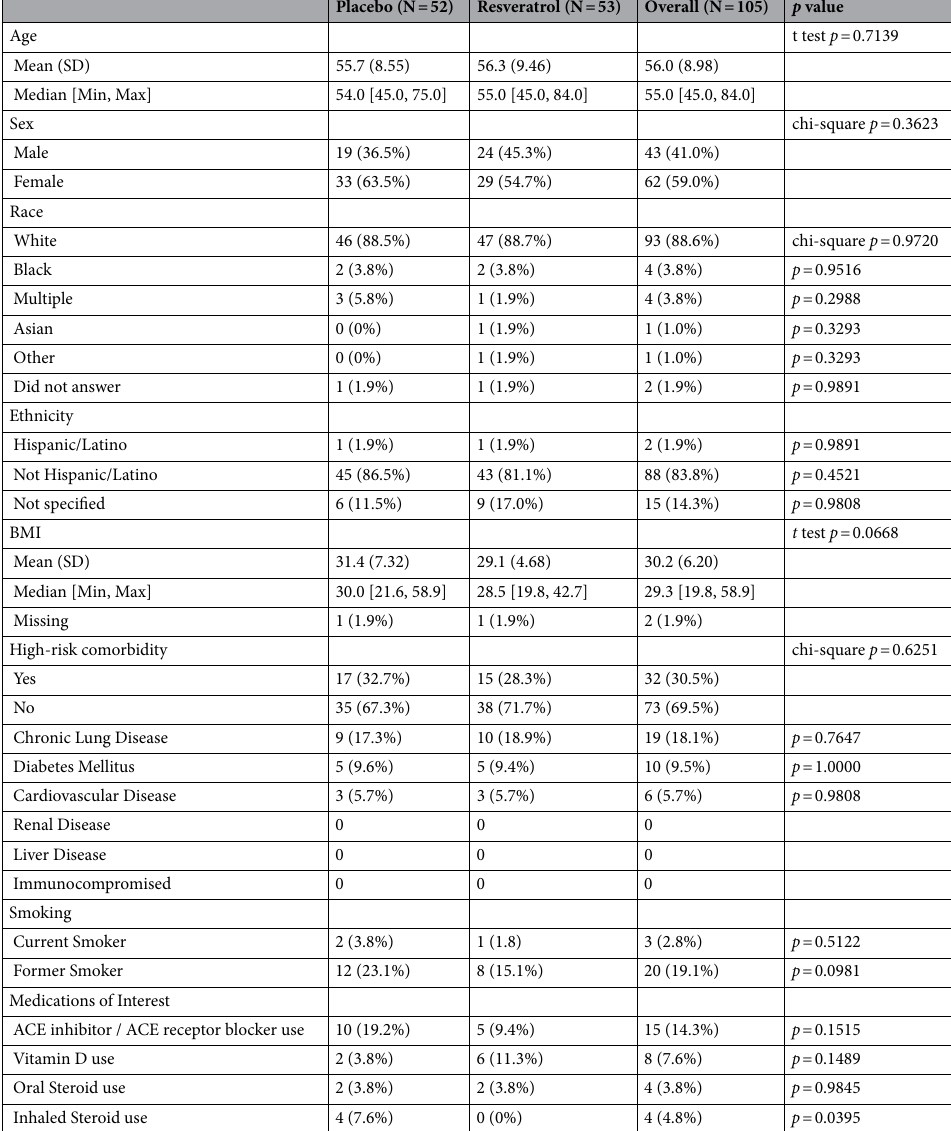
Table 1. Baseline characteristics of participants. SD = standard deviation; ACE = Angiotensin-converting enzyme. p -values not adjusted for multiple